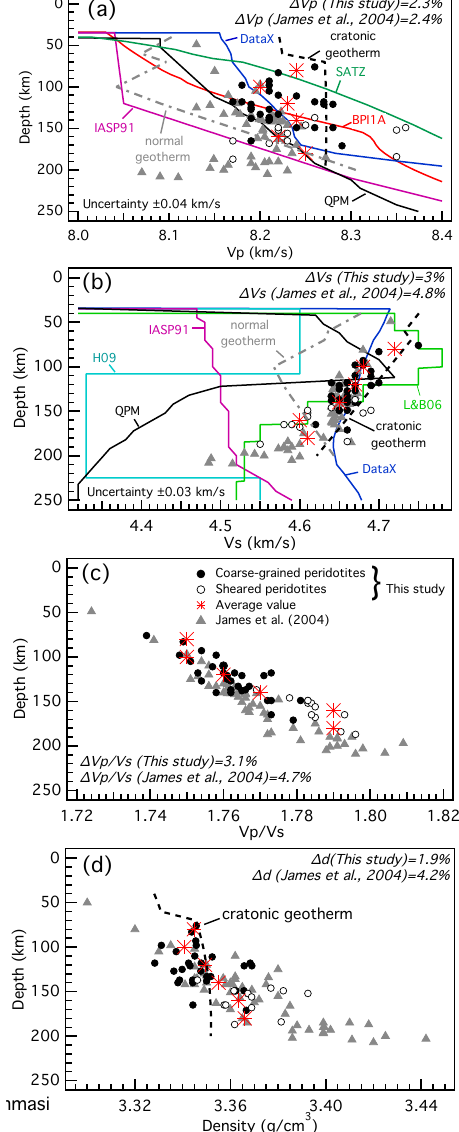
Fig. 5. Variation with depth of the isotropic seismic velocities and density of the studied peridotite xenoliths: (a) V p , (b) V s , (c) V p /V s ratio, and (d) density. For comparison, the density and seismic properties of a peridotite with a standard composition (between 40 and 70km: 65% olivine with Mg#90, 23% orthopyroxene, 12% clinopyroxene; between 70 and 200km: 65% olivine with Mg#90, 20% orthopyroxene, 10% clinopyroxene, 5% garnet) for both a “cratonic geotherm” as estimated by Baptiste et al. (2012) and a “normal geotherm” producing a 100km-thick lithosphere are shown as black and gray dashed lines, respectively. The IASP91 reference model and different seismic models for southern Africa (BPI1A: Simon et al., 2002; DataX: Larson et al., 2006; H06: Hansen et al., 2009; L&B06: Li and Burke, 2006; QPM: Qiu et al., 1996; SATZ: Zhao et al., 1999) are also shown (colored lines). Uncertainties in the seismic velocity estimates due to the uncertainty in the determi- nation of the equilibration pressure and temperature of the xenoliths are shown in (a) and (b)